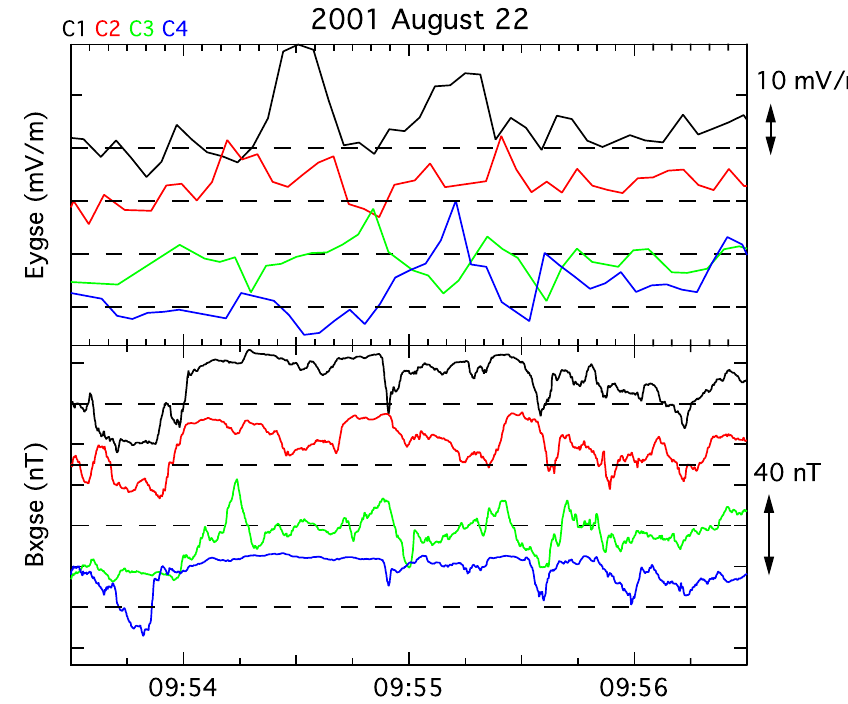
Fig. 7. Comparison between the simultaneous measurements of E y and B x from all four satellites during the plasma flow reversal.